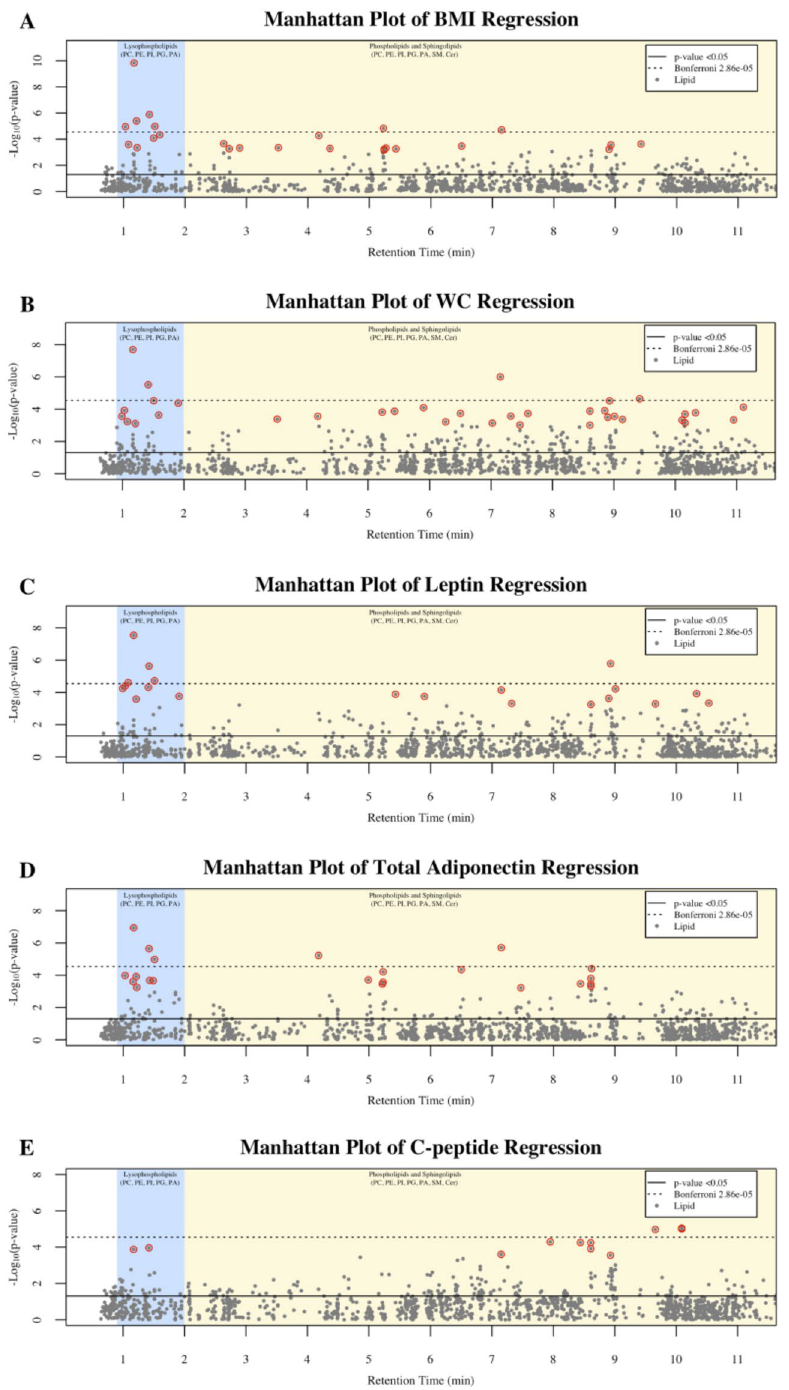
Figure 1. Manhattan plots of the –log10(p-value) for the traits: ( A ) BMI, ( B ) WC, ( C ) Leptin, ( D ) Total Adiponectin, and ( E ) C-peptide. Single lipid regression models defined as: Trait i = Age i + Smoking i + Lipid j where i = (1, … , 126) and j = (1, … , 1745). Each y-axis represents − log10(p-value) for each respective model, and each x-axis represent the retention time of the metabolite in minutes. Plasma lipid Benjamini-Hochberg false discovery corrected p-values < 0.05 are circled in red. Body mass index (BMI), waist circumference (WC), tumor necrosis factor-alpha (TNF- α ), interferon gamma-induced protein-10 (IP-10), interleukin-6 (IL-6), monocyte chemoattractant protein-1